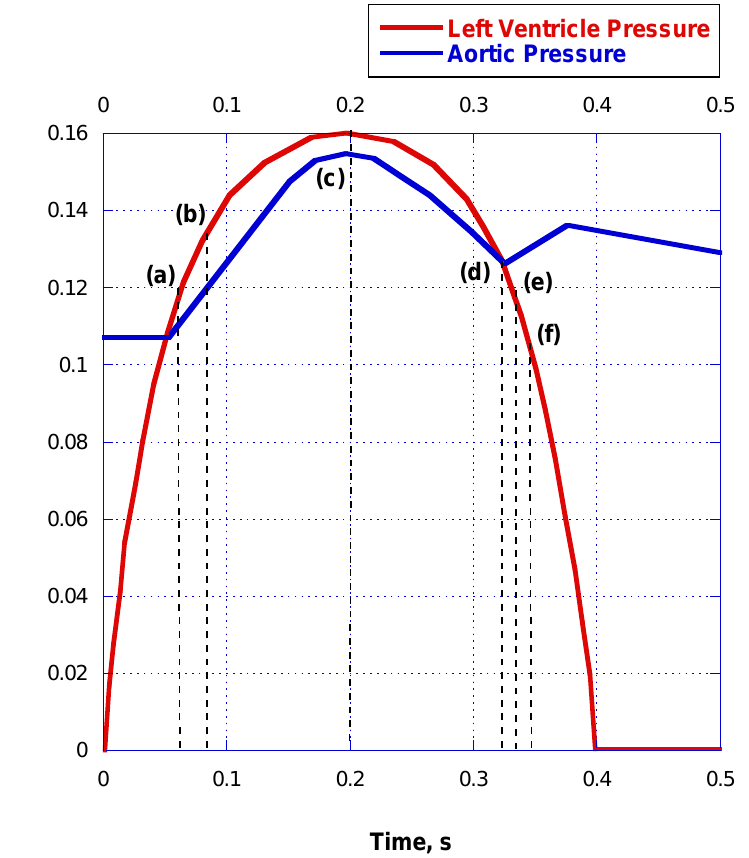
Figure 5. Time-varying pressure loading applied in the FEM simulation over a full cardiac cycle [7].